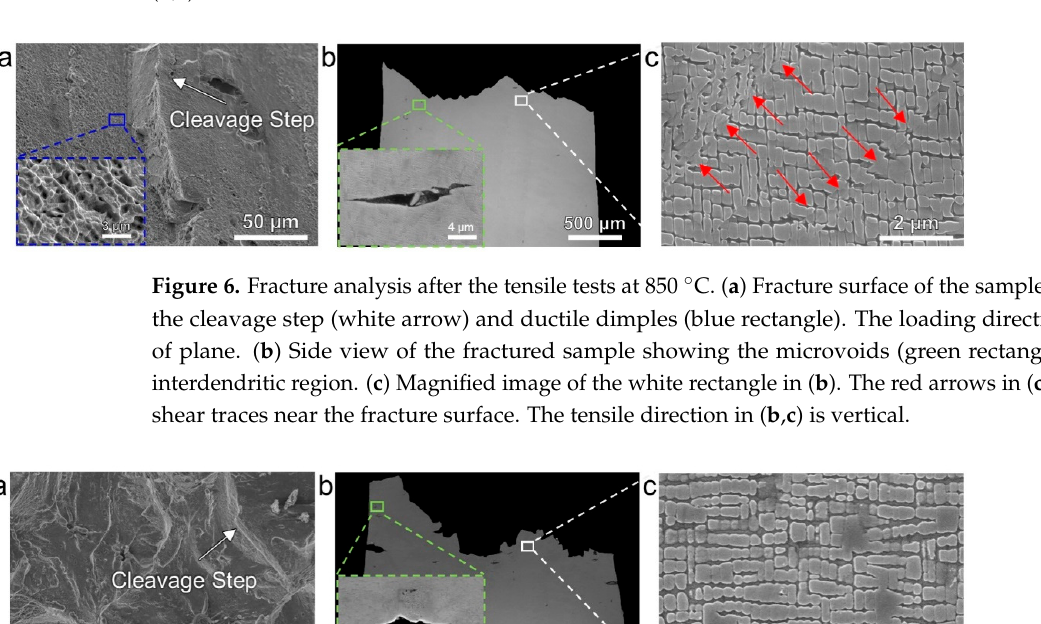
Figure 6. Fracture analysis after the tensile tests at 850 °C. ( a ) Fracture surface of the sample showing the cleavage step (white arrow) and ductile dimples (blue rectangle). The loading direction is out of plane. ( b ) Side view of the fractured sample showing the microvoids (green rectangle) in the inter- dendritic region. ( c ) Magnified image of the white rectangle in ( b ). The red arrows in ( c ) indicate shear traces near the fracture surface. The tensile direction in ( b , c ) is vertical. Figure 7. Fracture analysis after the tensile tests at 1050 °C. ( a ) Fracture surface of the sample showing the cleavage step (white arrow). The loading direction is out of the plane. ( b ) Side view of the fractured sample showing the microvoids (green rectangle) in the interdendritic region. ( c ) Magnified image of the white rectangle in ( b ), showing rafting microstructures. The tensile direction in ( b ) and ( c ) is vertical.